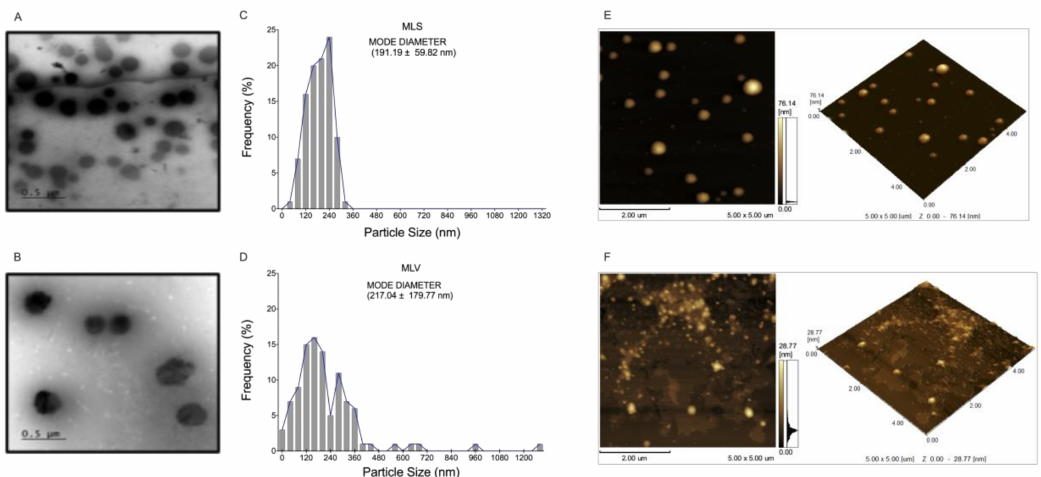
Figure 2. Characteristics of nanostructures: 1.- Morphological analyzed by transmission electron microscopy (TEM): ( A ) Mimetic lipid membranes containing N, N’ -Squaramide 17 (MLS) and ( B ) Empty mimetic lipid membranes (MLV). 2.- Class distribution histograms ( n = 100 particles) referring to the particle size values evaluated by transmission electron microscopy (TEM): ( C ) Mimetic lipid membranes containing N, N’ -Squaramide 17 (MLS) and ( D ) Empty mimetic lipid membranes (MLV). 3.- Characteristics of nanostructures analyzed by atomic force microscopy (AFM): ( E ) Mimetic lipid membranes containing N, N’ -Squaramide 17 (MLS) and ( F ) Empty mimetic lipid membranes (MLV). Acquired in dynamic mode. Scanning area 5 µ m × 5 µ